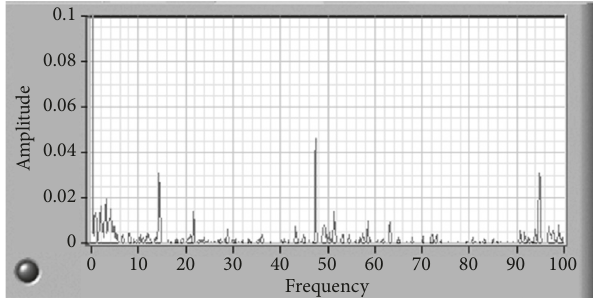
Figure 5: Filtered FFT signal of the acceleration (g), corresponding to 0 mm and 60 m/min.